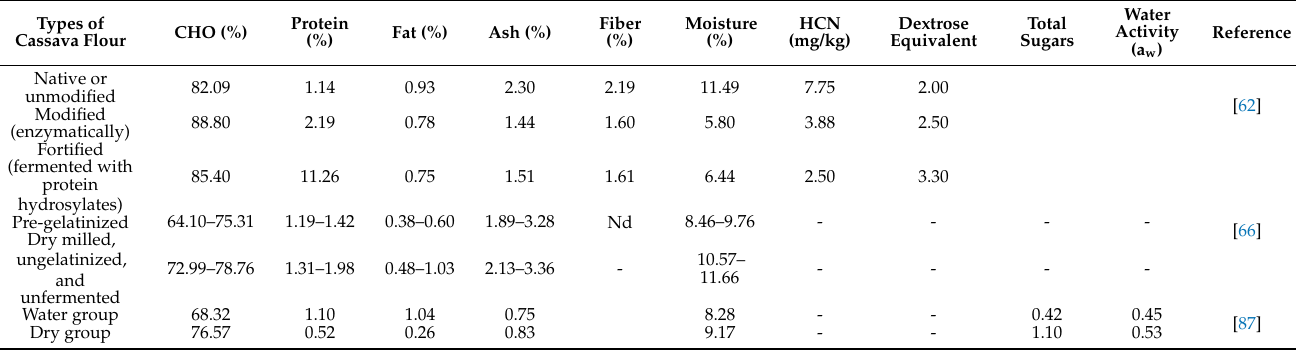
Table 2. Types of cassava flour: physicochemical composition.